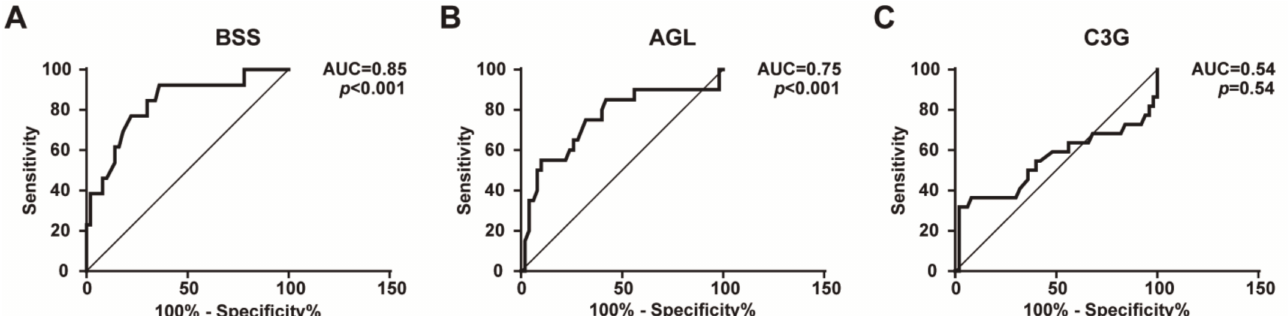
Figure 2. Plasma FD levels ROC curves for samples from patients with Barraquer–Simons syndrome (BSS) ( A ), patients with acquired generalized lipodystrophy (AGL) ( B ), and patients with C3 glomerulopathy (C3G) ( C ). p < 0.05 was considered statistically significant. AUC, area under the ROC